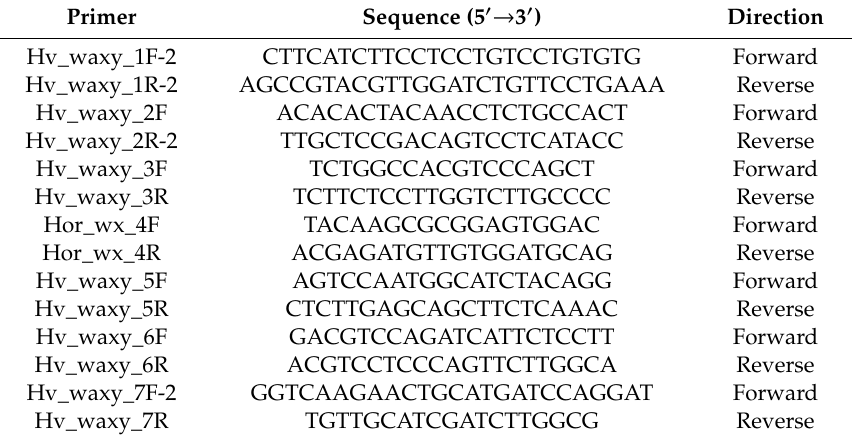
Table 1. Primers used for the Waxy gene amplification.